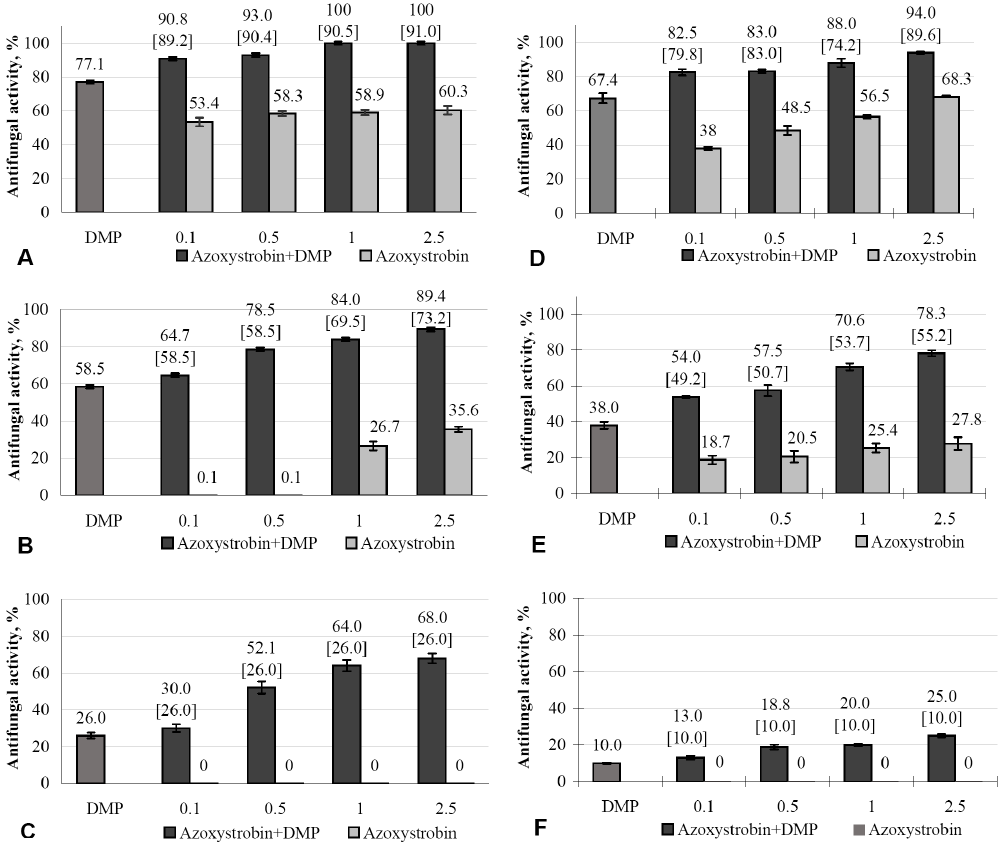
Figure 8. Antifungal activity of the DMP (7.5 g/L) and azoxystrobin (0–2.5 mg/L) combinations towards Fusarium gra- minearum FG-33 (left, A – C ) and F. avenaceum 110501 (right, D – F ). Regular numbers indicate the experimental values of antifungal activity ( E R , p ≤ 0.05) and numbers in brackets correspond to the expected E E value ( p ≤ 0.05) calculated ac- cording to Richer et al. (1987). The data obtained after 3 ( A , D ), 7 ( D , E ) and 14 ( C , F ) days of incubation. The typical appearance of Petri plates with the studied pathogens and combinations of preparations are shown in Figure 9.